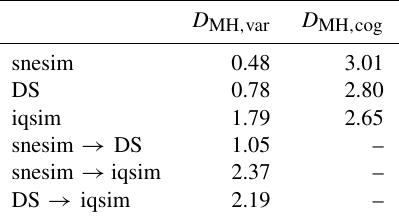
Table 3. Summary of the modified Hausdorff distance ( D MH ) ma- trix portraying the D MH results. D MH , var presents the variability of the given MPS method or between the different MPS methods; for example, the value in the D MH , var column and the snesim → DS row represents the average distance between the snesim and DS re- alizations. The D MH , cog is the average distance from the simulation results to the cognitive model. D MH ,